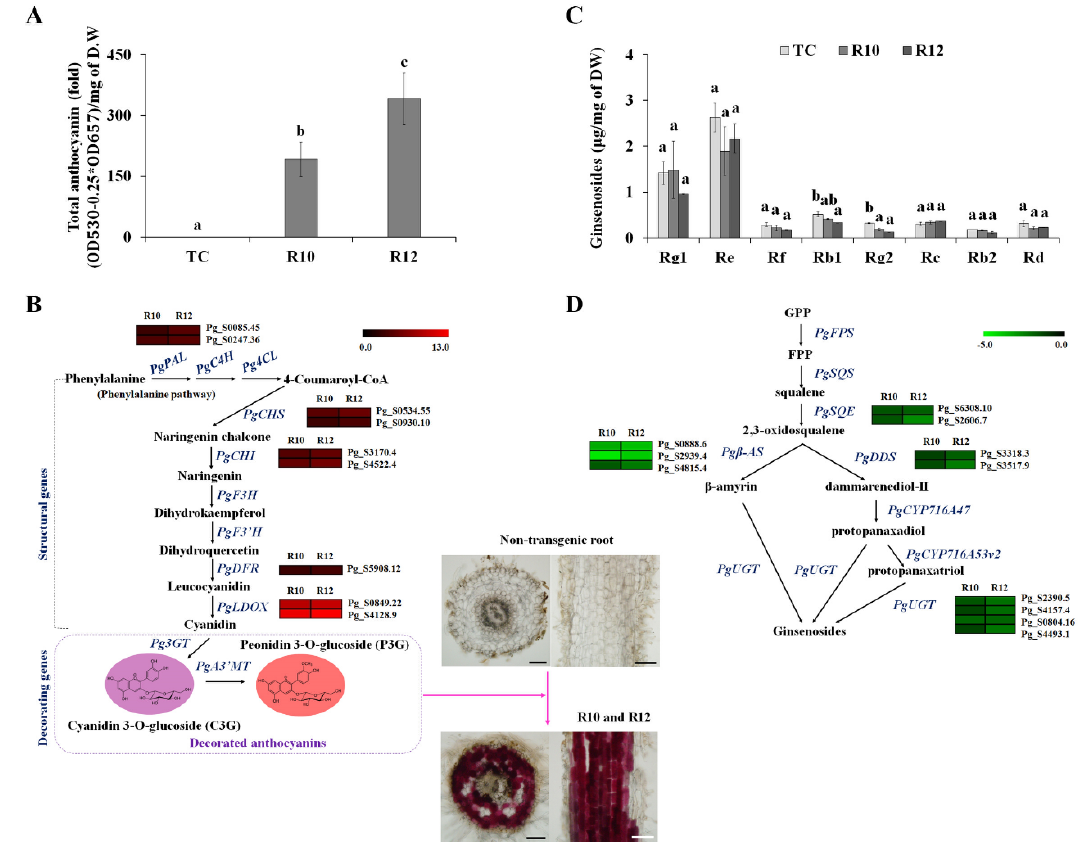
ff ect of PAP1 on the anthocyanin and ginsenoside biosynthetic pathways. Figure 3. Effect of PAP1 on the anthocyanin and ginsenoside biosynthetic pathways. Anthocyanin Figure 3. E